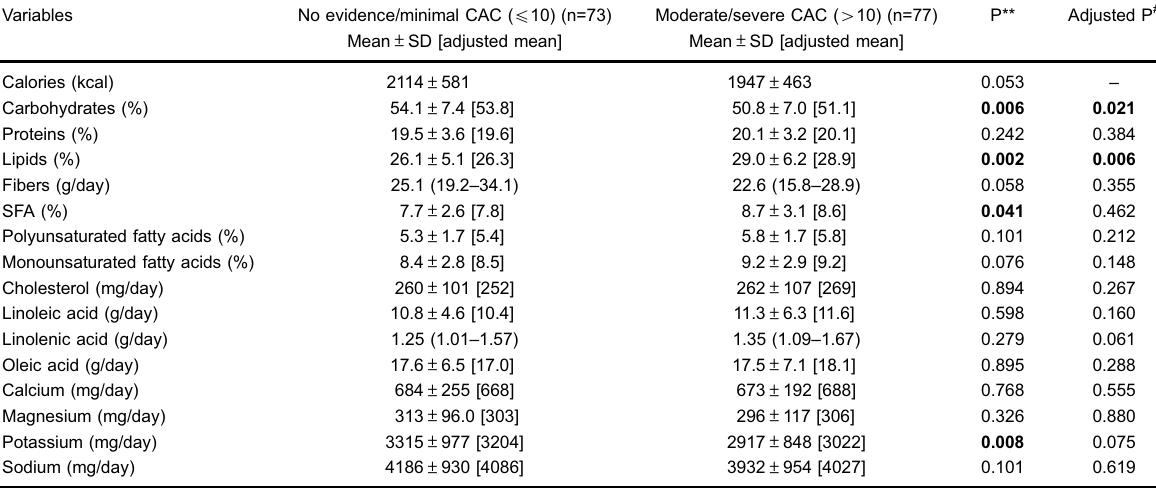
Table 3. Association between the intake of calories, macronutrients, and micronutrients with coronary artery calci fi cation (CAC).